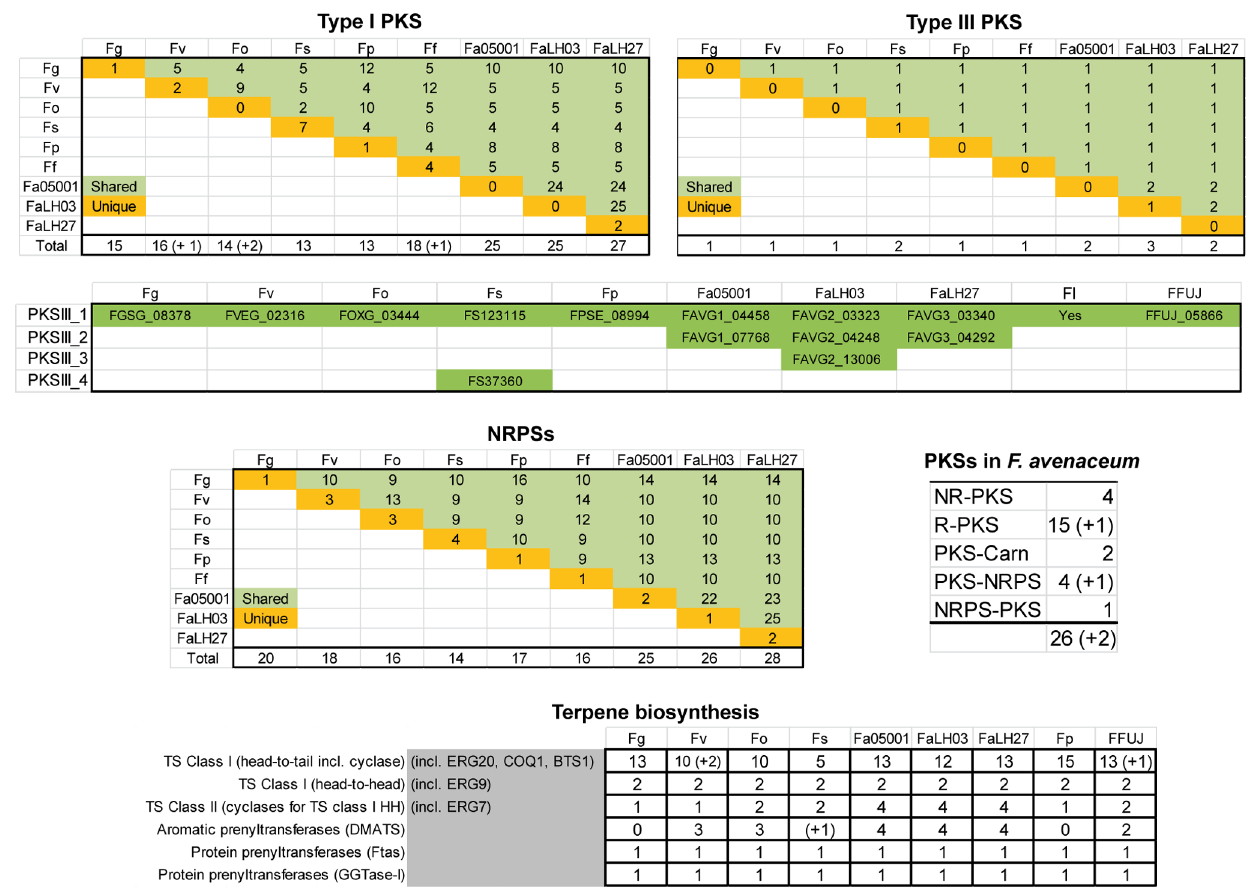
Figure 5. Shared and unique polyketide synthase (PKS), non-ribosomal peptide synthetases (NRPS) and terpene cyclase (TC) encoding genes in public available Fusaria genomes. Green and yellow boxes are the number of shared and unique genes, respectively. Fg = F. graminearum, Fv = F. verticillioides, Fo = F. oxysporum , Fs = F. solani, Fp = F. pseudograminearum, Ff = F. fujikuroi and Fa05001, FaLH03 and FaLH27 = F. avenaceum .